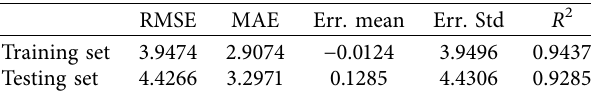
Figure 9: Error between target and output values plots for the case of the best ANN structure containing 24 neurons ANN-[8-24-1]: (a) training dataset and (b) testing dataset. Table 5: Summary of different quality assessment criteria for the best ANN predictor using 24 neurons in the hidden layer, denoted as